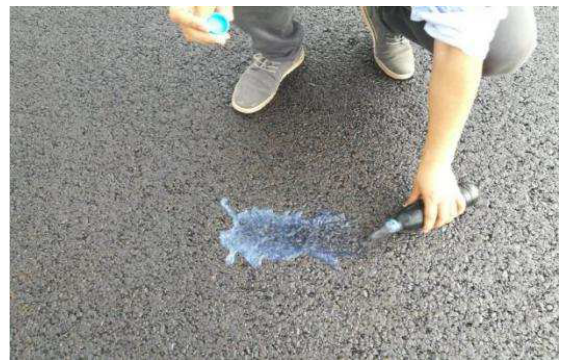
Figure 9. Active ingredient test of snow-melting salt.